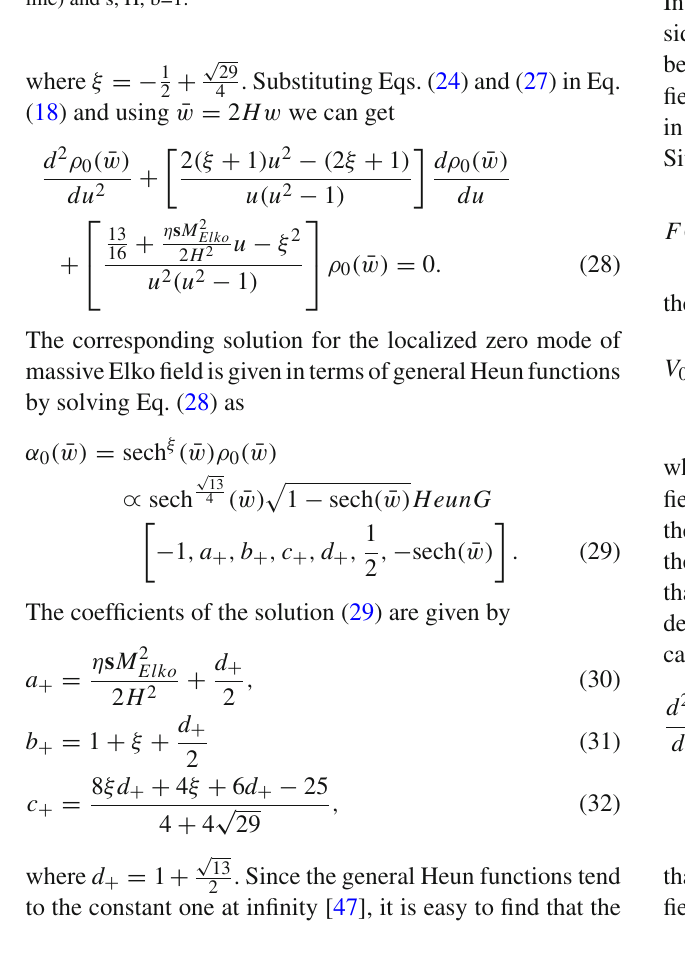
( a ) = 0 (dotted line), Elko = 3 (thin line), M 2 = 5 (thick Elko Elko